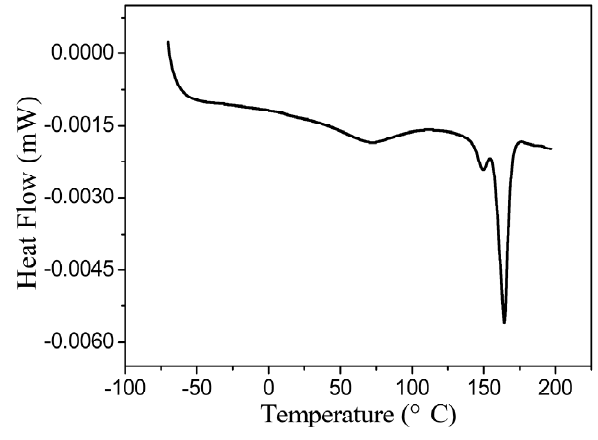
Figure 3. DSC curves of PLA (the PLA was synthesized in toluene-THF (toluene/THF = 2), Lac-OCA concentration = 1.67 mol/L, M/I = 150, temperature = 25 °C and reaction time = 4